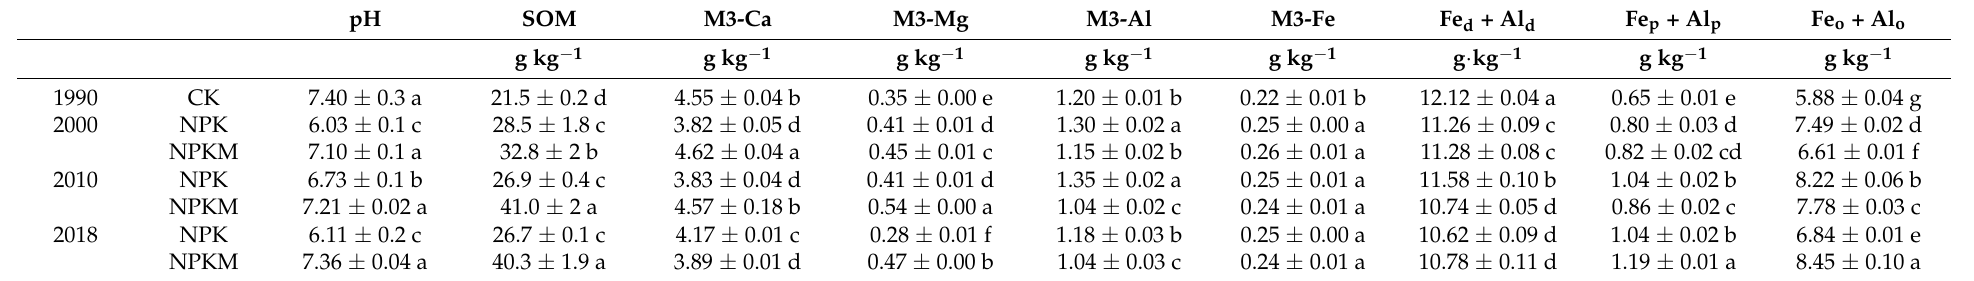
Table 4. Soil properties of collected samples in